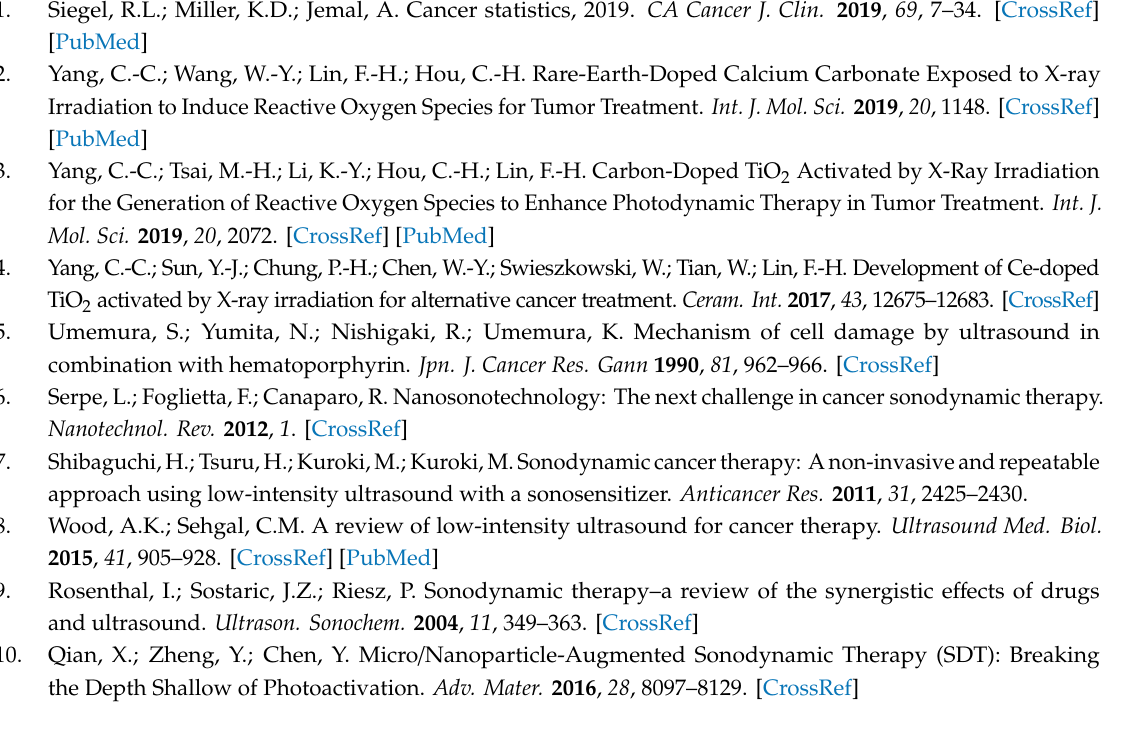
Figure S1: Live / Dead assay; Figure S2: survival rate of BALB / c nude mice; Figure S3: average weight of BALB / c nude mice; Figure S4: H&E-stained images of